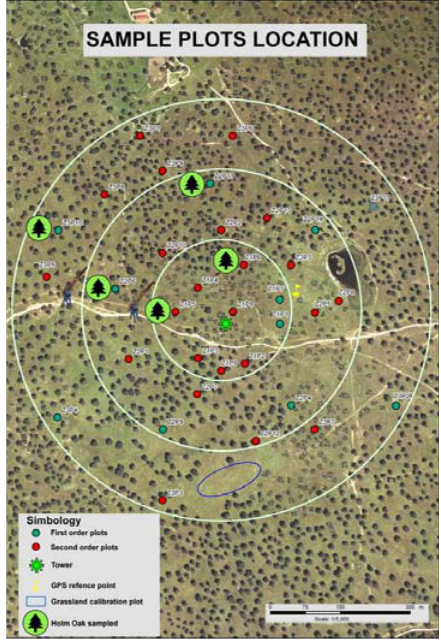
Figure 5. Scheme of Biospec protocol for optical and biophysical